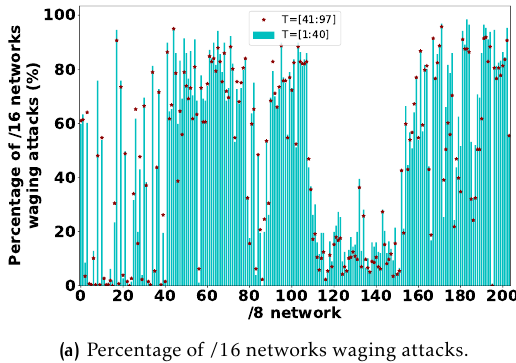
attacking networks. This also explains why Figure 3a does not show a significant drop at t = 41.